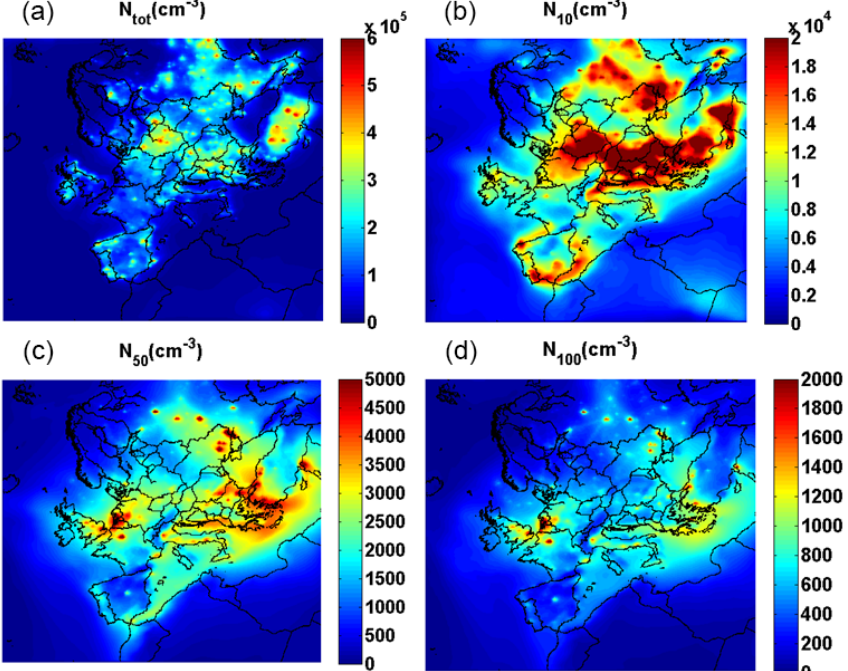
Figure 1. The simulated spatial distribution of the arithmetic mean of ground-level number concentration during May 2008 for particles larger than (a) 0.8nm ( N tot ), (b) 10nm ( N 10 ), (c) 50nm ( N 50 ), and (d) 100nm ( N 100 ). The PMCAMx-UF baseline simulation ACDC-TUV-DE is used (see Table 1). Note that different color bar scales are used for the different size ranges for readability.